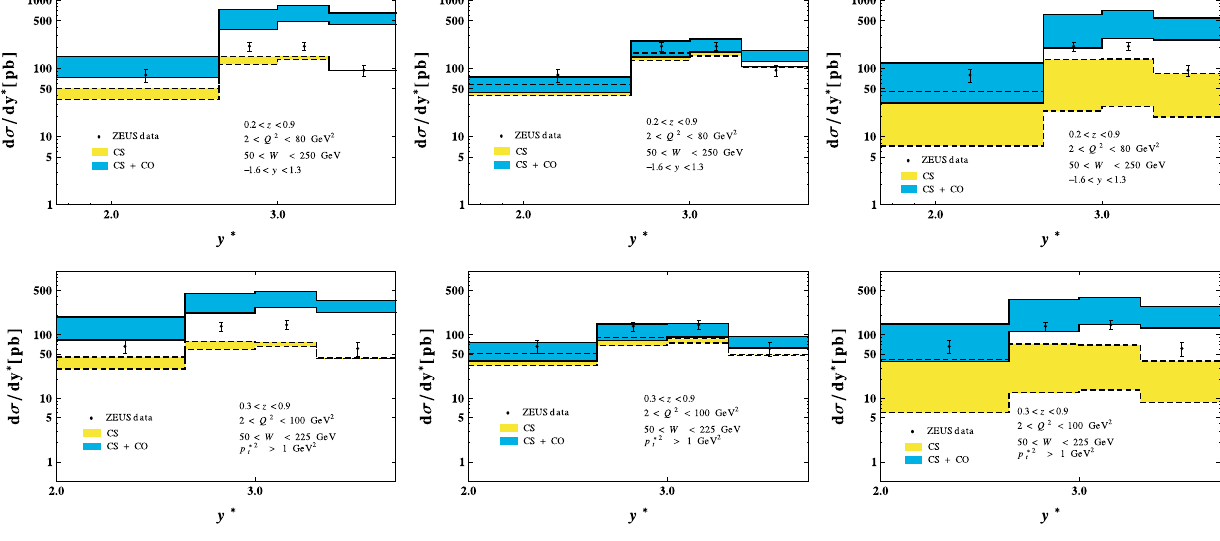
Fig. 14 The differential cross sections for the J /ψ production in DIS with respect to y (cid:11) ψ . The experimental data are taken from Ref. [51]. The l.h.s., middle, and r.h.s. plots correspond to the LDMEs taken in Refs. [28,30,41],